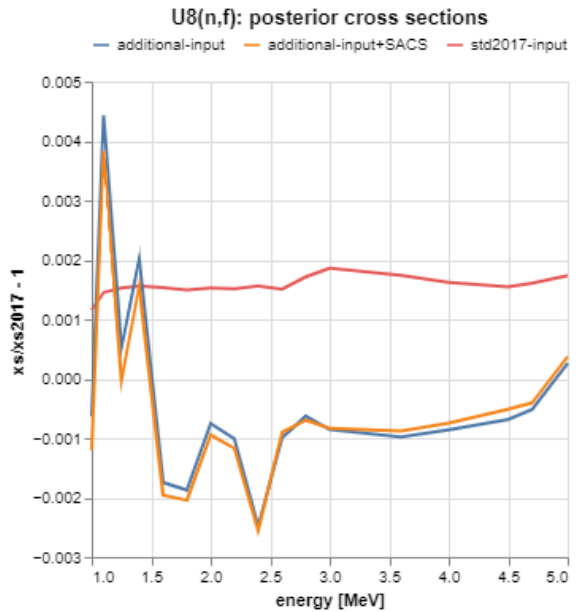
Figure 2: Evaluated 238 U(n,f) cross sections relative to the IAEA STD 2017 [3] from 1 MeV up to 5 MeV.